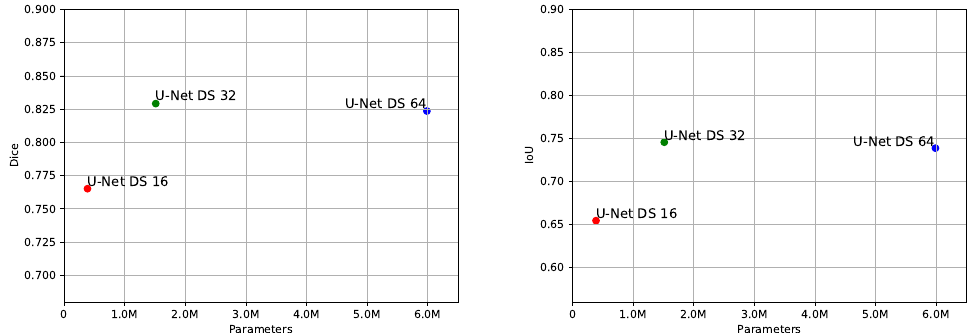
Figure 13. Comparison of the U-Net DS changing values of C to 16, 32 and 64 in Dice and IoU scores vs. number of